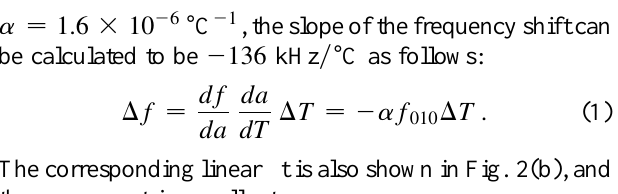
FIG. 2. (a) Gun power reflection as a function of frequency. The horizontal axis runs from 8.547 to 8.548 GHz with each division being 100 kHz, and the vertical axis runs from 0 to 2 100 dB with each division being 10 dB. (b) Gun resonance frequency as a function of temperature. The line is the theoreti- cal prediction [Eq. (1)] and the points are measured values.